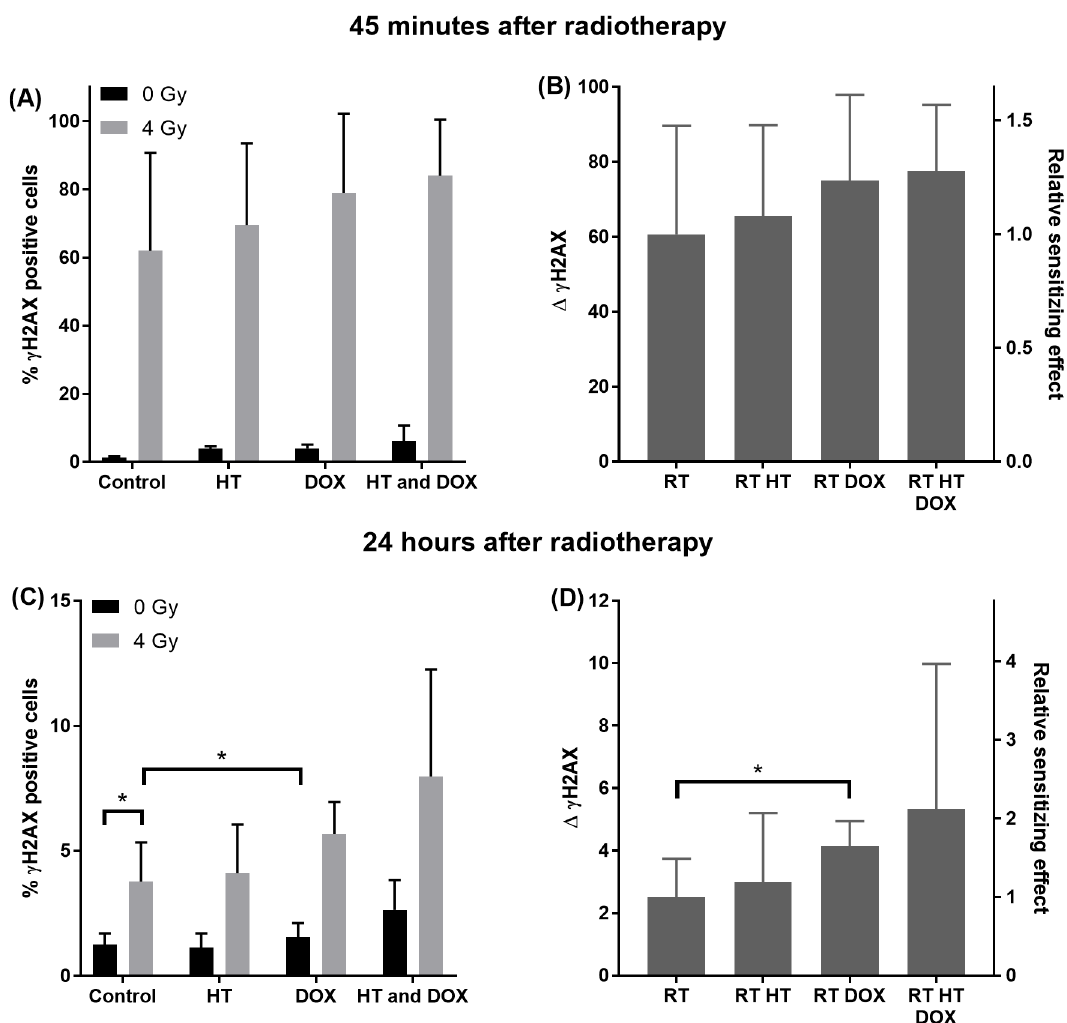
Fig 7. γ H2AX staining after cells treated with DOX, HT and/or RT. Percentage γ H2AX positive cells after incubated with DOX (0 or 0.02 μ g/ml) for 1 hour at 37 or 43˚C and irradiated at 0 or 4 Gy, 45 minutes (A and B) or 24 hours (C and D) after irradiation. Expressed in percentage γ H2AX positive cells (A and C) and expressed in difference in percentage γ H2AX cells of treatment with and without RT (0 and 4 Gy) and expressed in relative sensitizing effect (B and D).